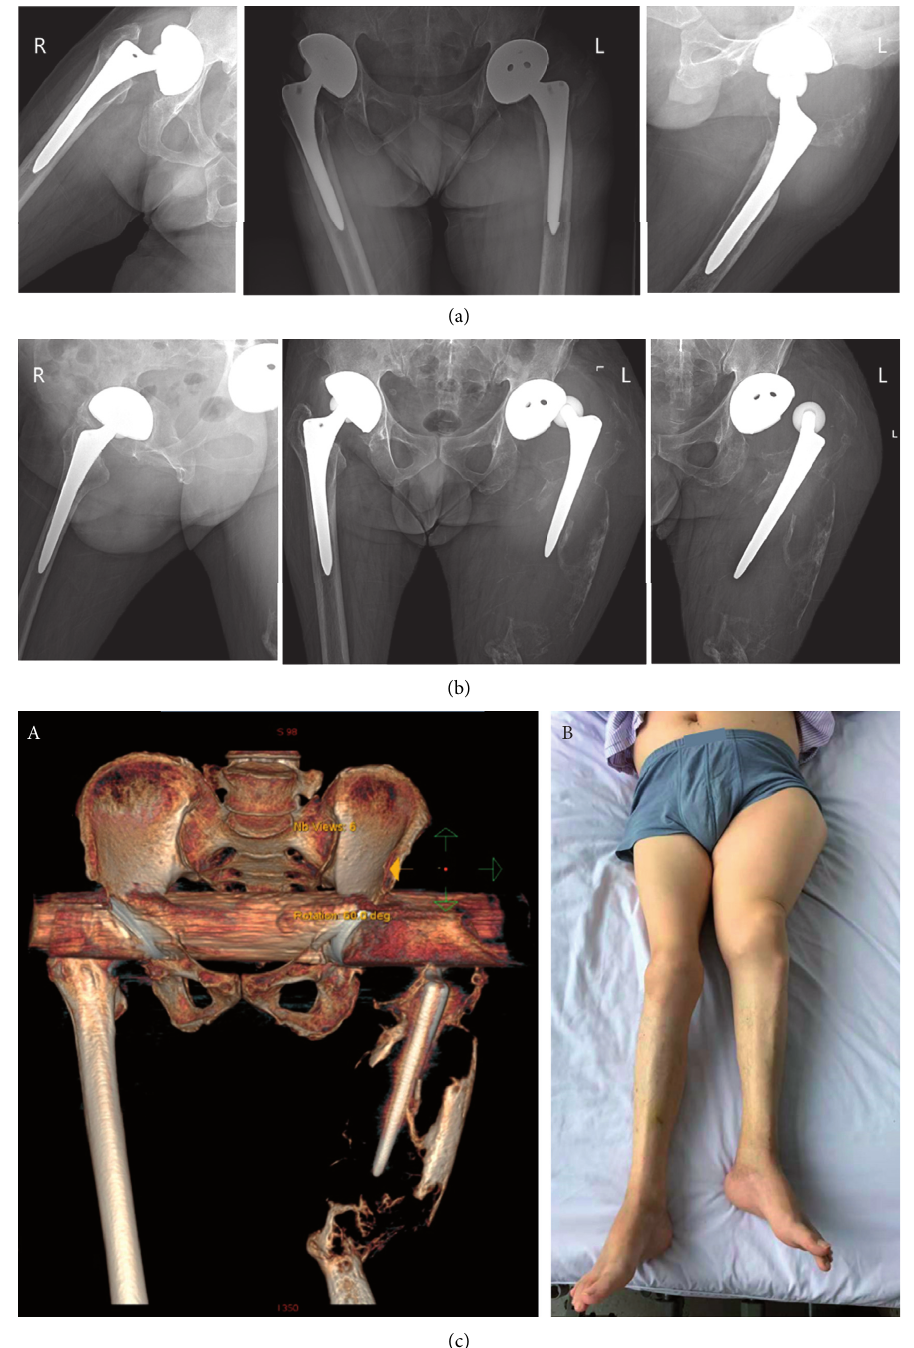
Figure 1: X-ray photography of hip joints of Patient 1. (a) Taken two months after trauma. (b) Taken eight months after trauma, nearly the entire left femur displayed a characteristic “soap bubble” appearance, and the femoral stem “floated” in a large pseudotumor. (c) CT reconstruction (A) and general photography (B) taken eight months after